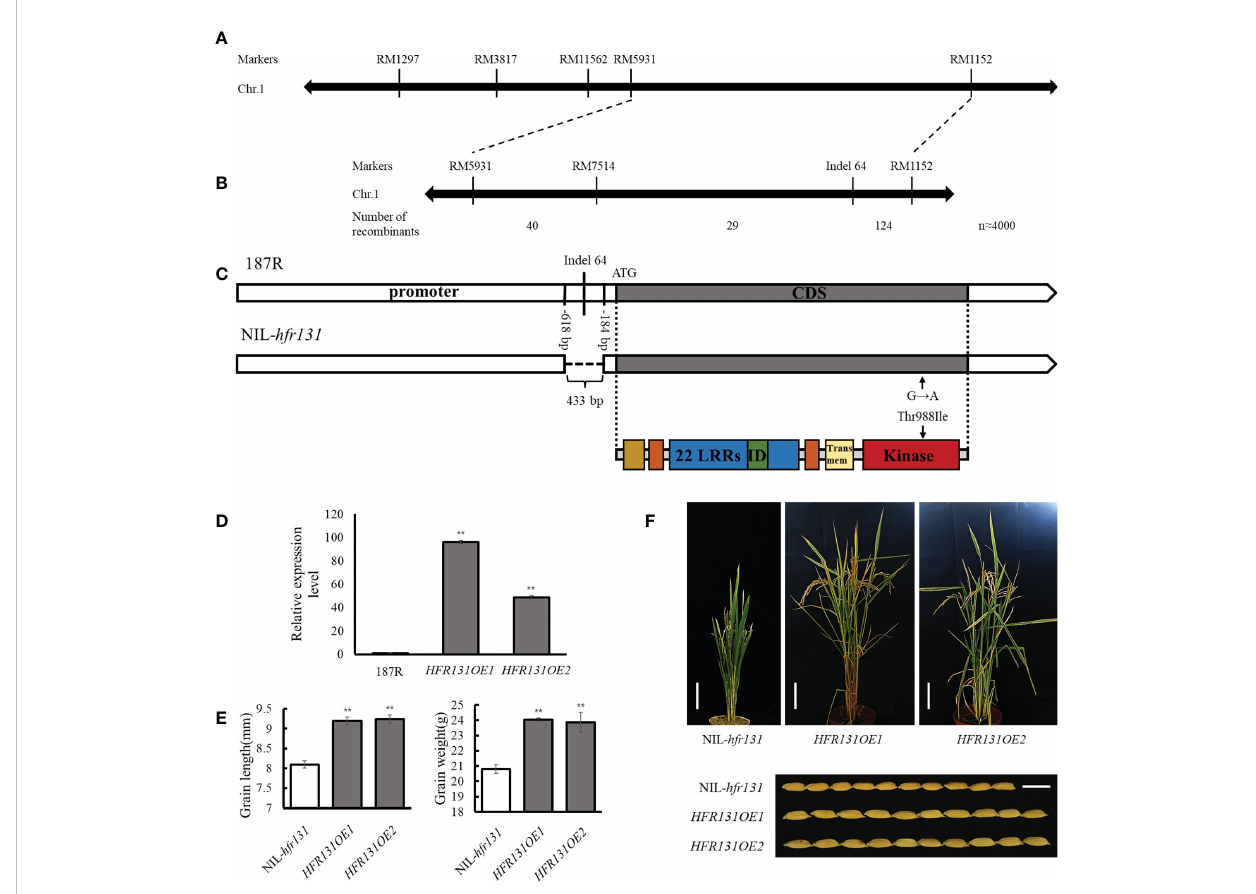
FIGURE 3 Identi fi cation of HFR131 . (A) Linkage map of HFR131 . (B) Fine mapping of HFR131 using almost 4000 F 2 plants. The number of recombinants between adjacent markers is indicated under the linkage map. (C) Gene structure of OsBRI1 in rice ‘ 187R ’ and NIL- hfr131 , and the corresponding protein structure redrawn from Nakamura et al. (Nakamura et al., 2006). Positions of the 433 bp deletion are presented by base number before the ATG. (D) Transgene expression level of OsBRI1 / HFR131 . OsActin was used as an internal reference. (E) Grain length and thousand-grain weight of NIL- hfr131 and HFR131 overexpression lines (T 0 generation). (F) Plant architecture (Bar = 10 cm) and grain morphology (Bar = 1 cm) of NIL- hfr131 and HFR131 overexpression lines (T 0 generation). The plant height of NIL- hfr131 , HFR131OE1 and HFR131OE2 is 50.9 cm, 68 cm and 66 cm, respectively. ** P <